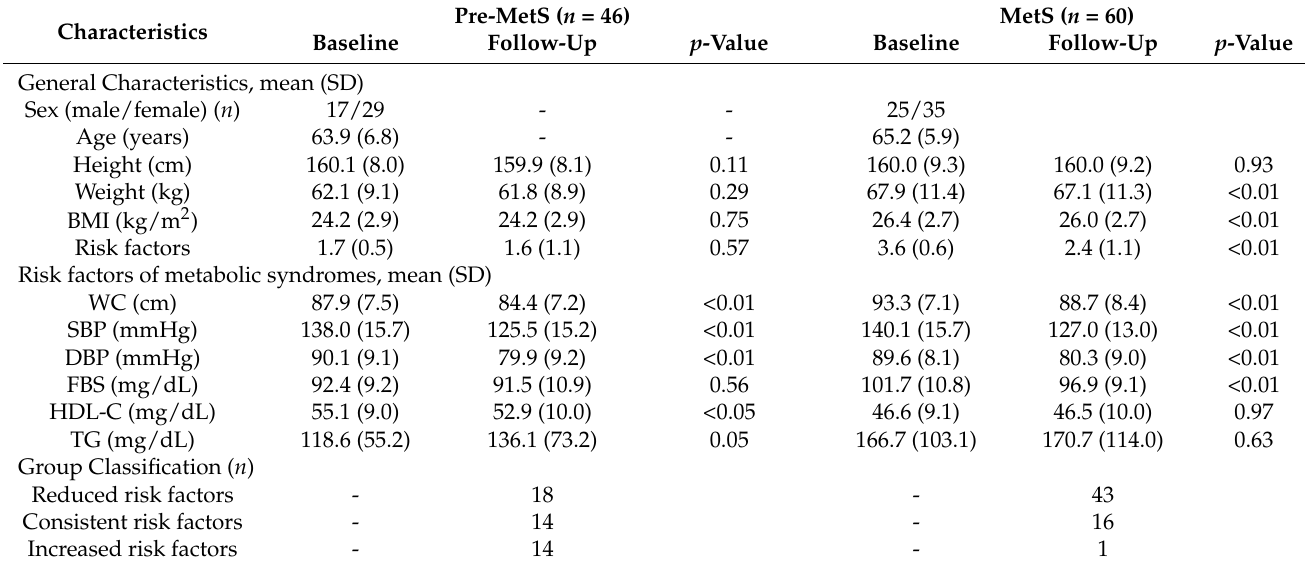
Table 1. Participant characteristics at baseline and follow-up assessments.